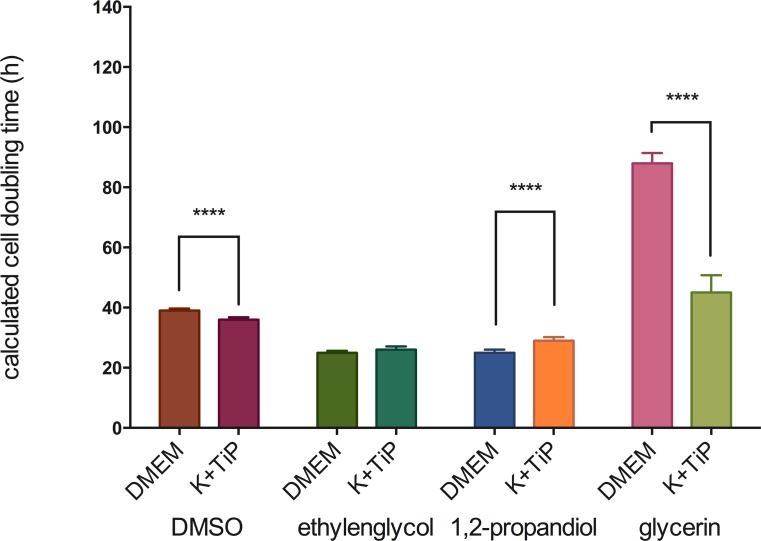
Cell doubling-time after the use of slow freezing methods.Figure 3 illustrates MHEC-5T doubling-time after the use of slow freezing methods. DMEM = DMEM Ham’s F-12 Gln+, 20% FBS, and 1.5M of one of the CPAs; K+TiP = K+TiP. 0.5M sucrose, 20% FBS, and 1.5M of one of the CPAs; **** = highest siginificance (p < 0.0001).